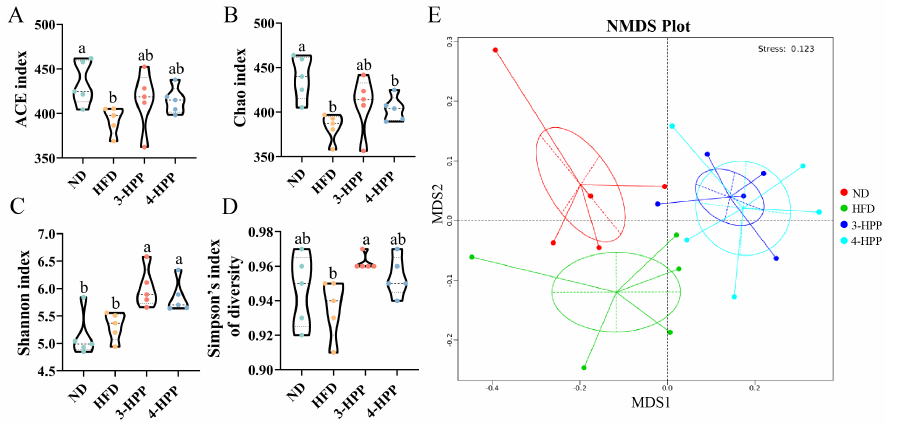
Figure 4. The impacts of 3 − HPP and 4 − HPP on α and β diversity of gut flora. ACE ( A ), Chao ( B ), and Shannon ( C ) indexes. ( D ) Simpson’s index of diversity ACE. ( E ) NMDS analysis based on Weighted Unifrac distance. Data are expressed as mean ± SD. n = 5 if not specified. According to Duncan’s test, mean values with different letters denote significant differences at p < 0.05.